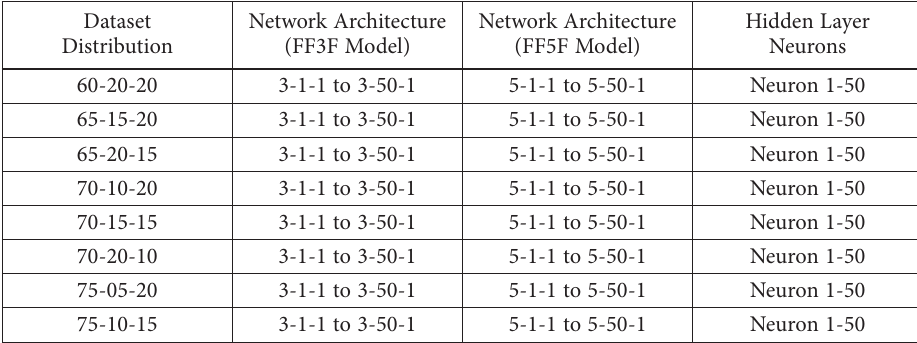
Table 1. Distribution of Dataset (Training, Validation, and